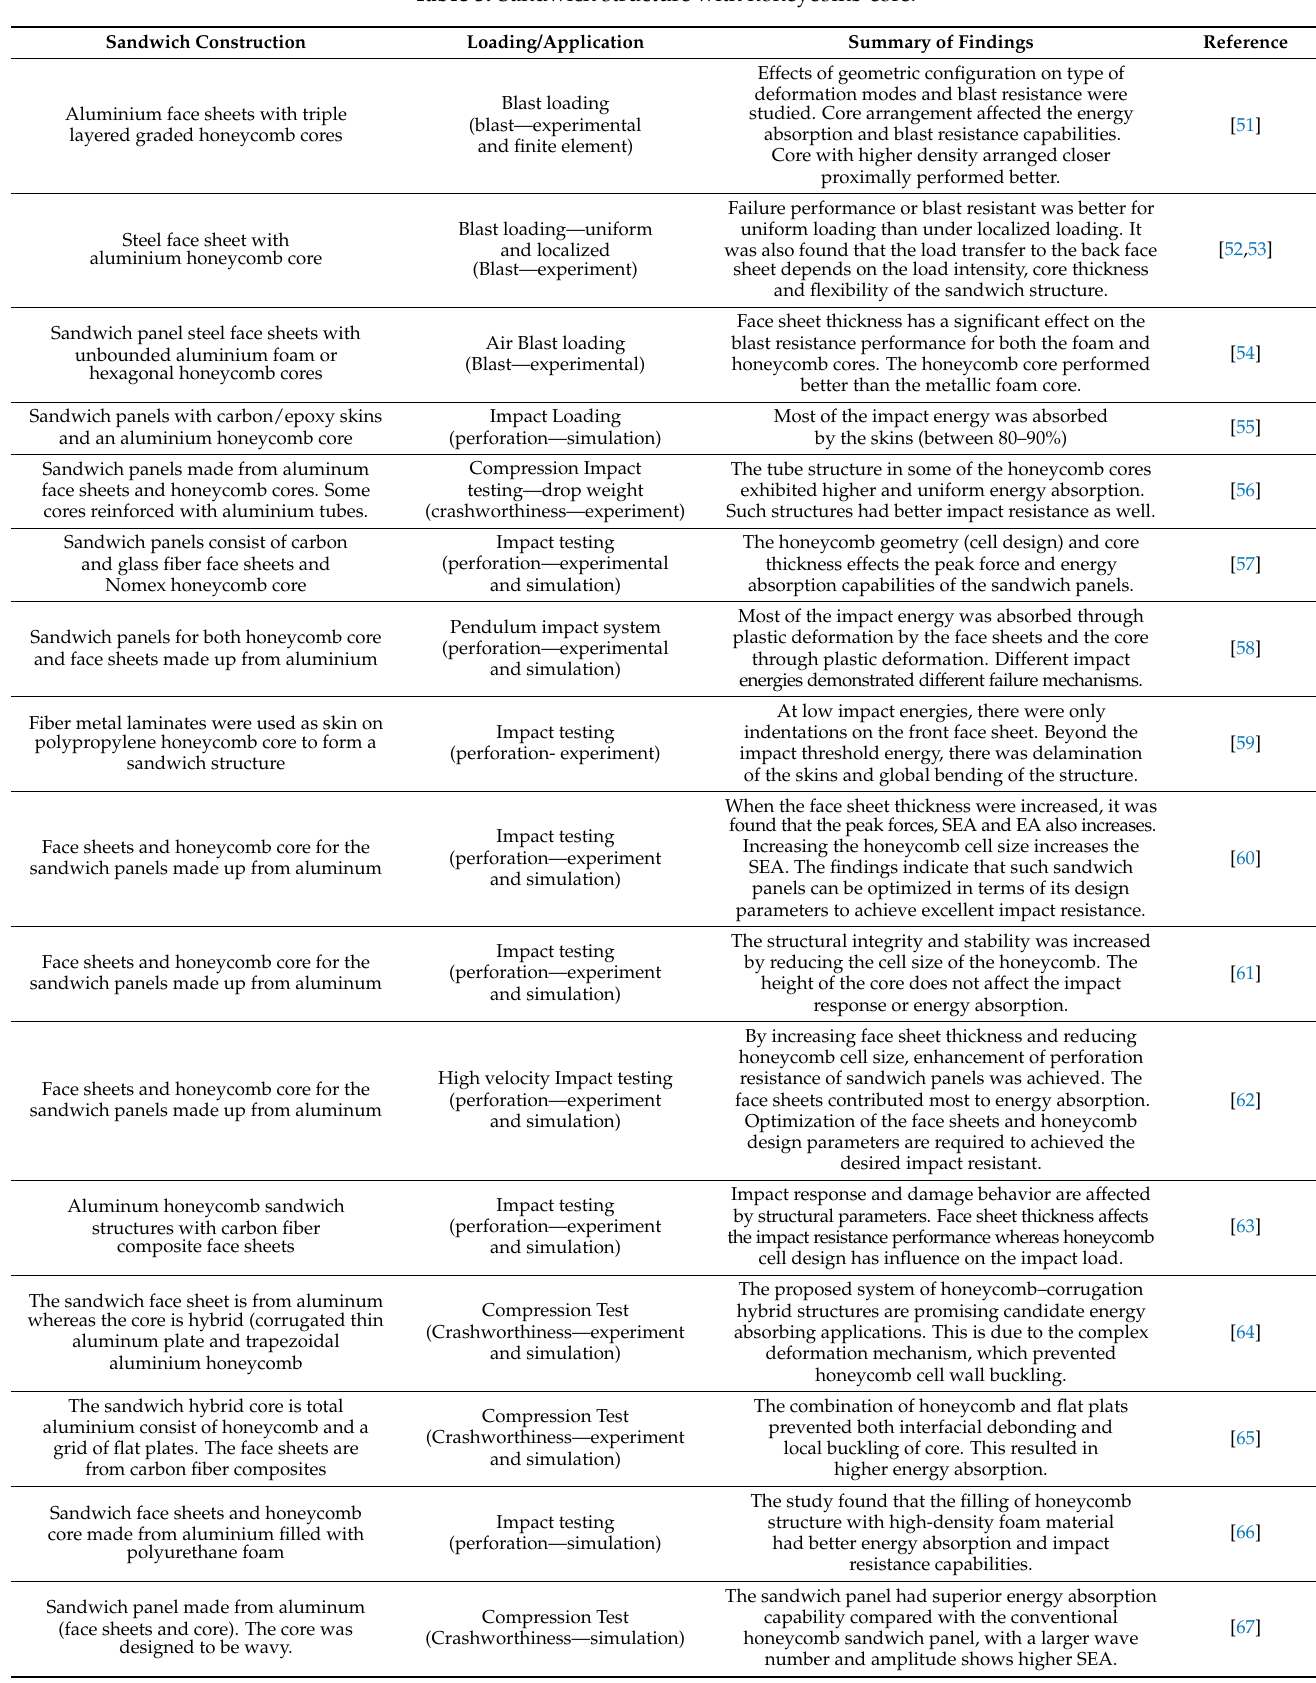
Table 3. Sandwich structure with honeycomb